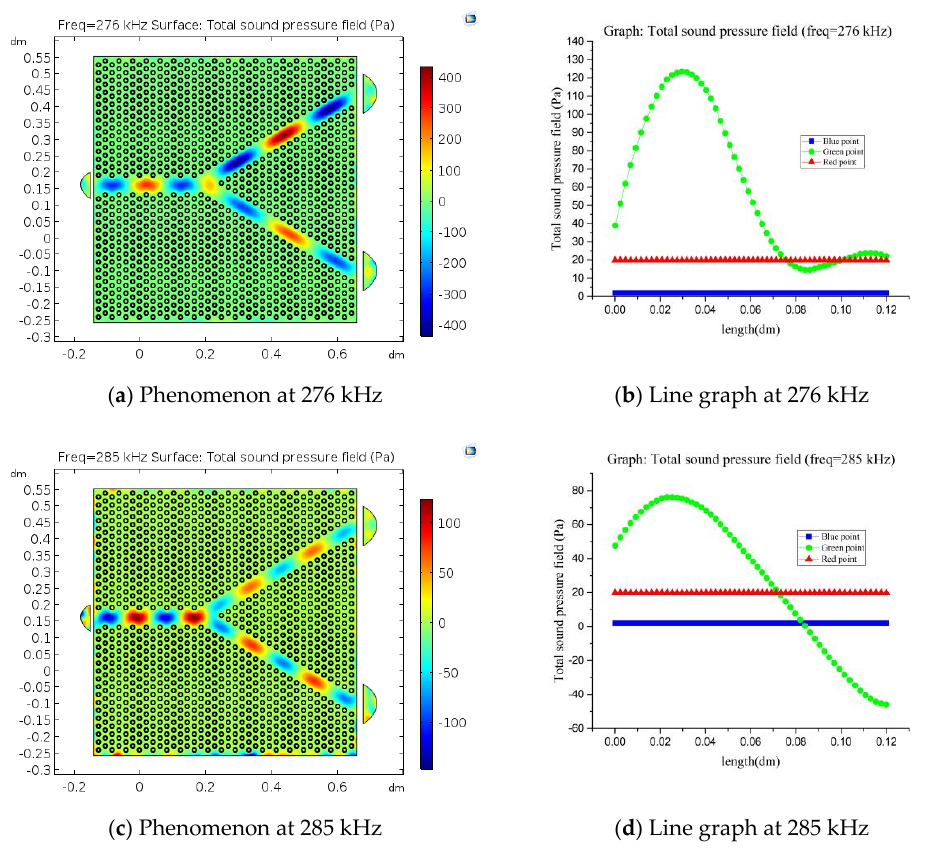
Figure 6. The effect of the sound pressure at the switch point:( a ) Phenomenon at 276 kHz; ( b ) line graph at 276 kHz; ( c ) phenomenon at 285 kHz; ( d ) line graph at 285 kHz.